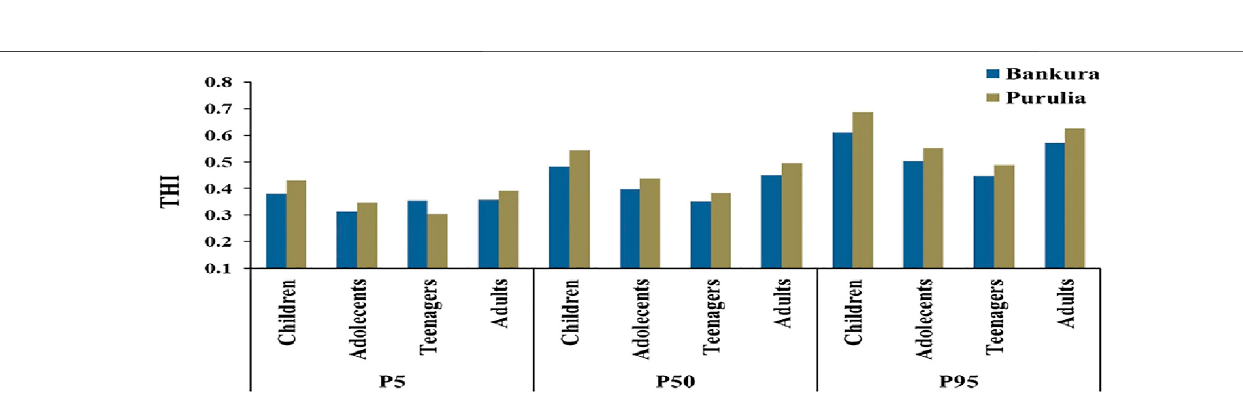
Frontiers in Environmental Science |